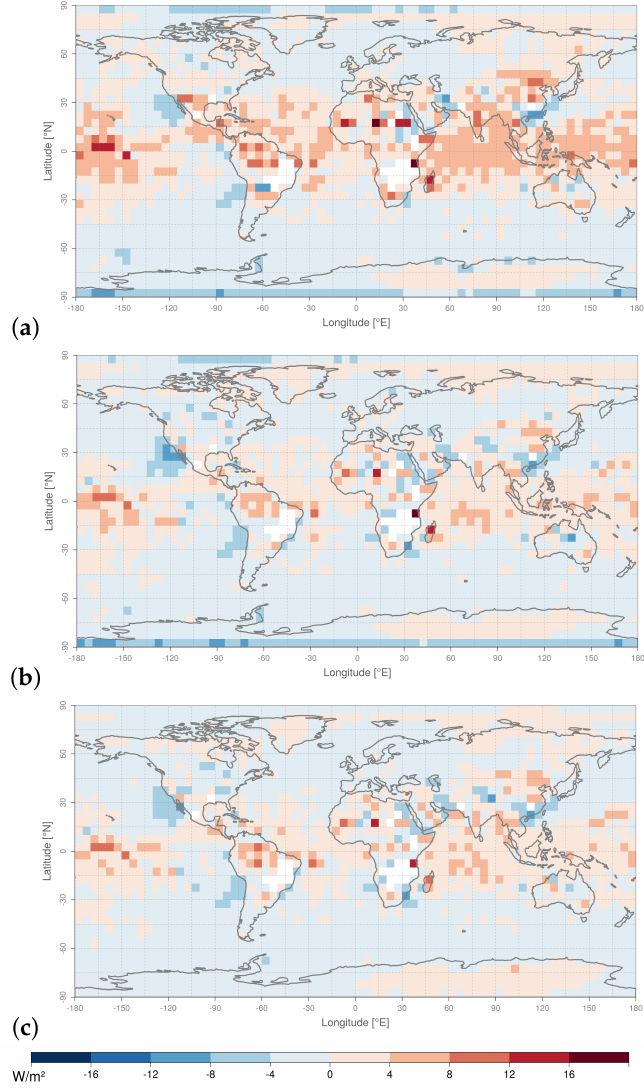
Figure 4. Flux-equivalent Mean Bias ( MB flux ) between observed and estimated broadband reflectance, for overcast conditions; estimated values are calculated by applying surface-type-dependent regressions on the narrowband observations, using the predictors: ( a ) channels 1 + 2, ( b ) channels 1 + 2 and SZA, and ( c ) channels 1 + 2, SZA and VZA. Biases are calculated on expanded validation database (with relaxed matching